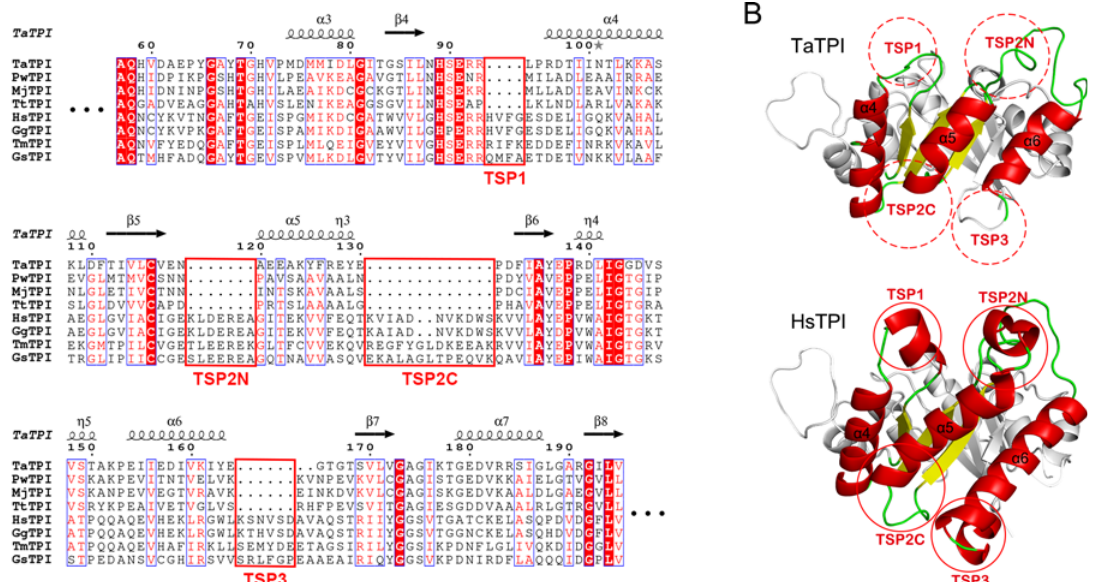
Fig 3. TPI stabilization patches (TSPs). (A) Structure-based sequence alignment of TaTPI with other TPIs from Pyrococcus woesei (PwTPI), Methanocaldococcus jannaschii (MjTPI), Thermoproteus tenax (TtTPI), Homo sapiens (HsTPI), Gallus gallus (GgTPI), Thermotoga maritima (TmTPI), and Geobacillus stearothermophilus (GsTPI). Strictly conserved amino acid residues are highlighted in red shaded boxes and moderately conserved amino acid residues are colored in red. Conserved residues are enclosed in blue boxes and TSP regions are enclosed in red boxes. The alignment figure was prepared using ESPript program [32]. (B) Structural comparison of TaTPI and HsTPI. The red dotted and solid circles represent TSP regions in TaTPI and HsTPI,